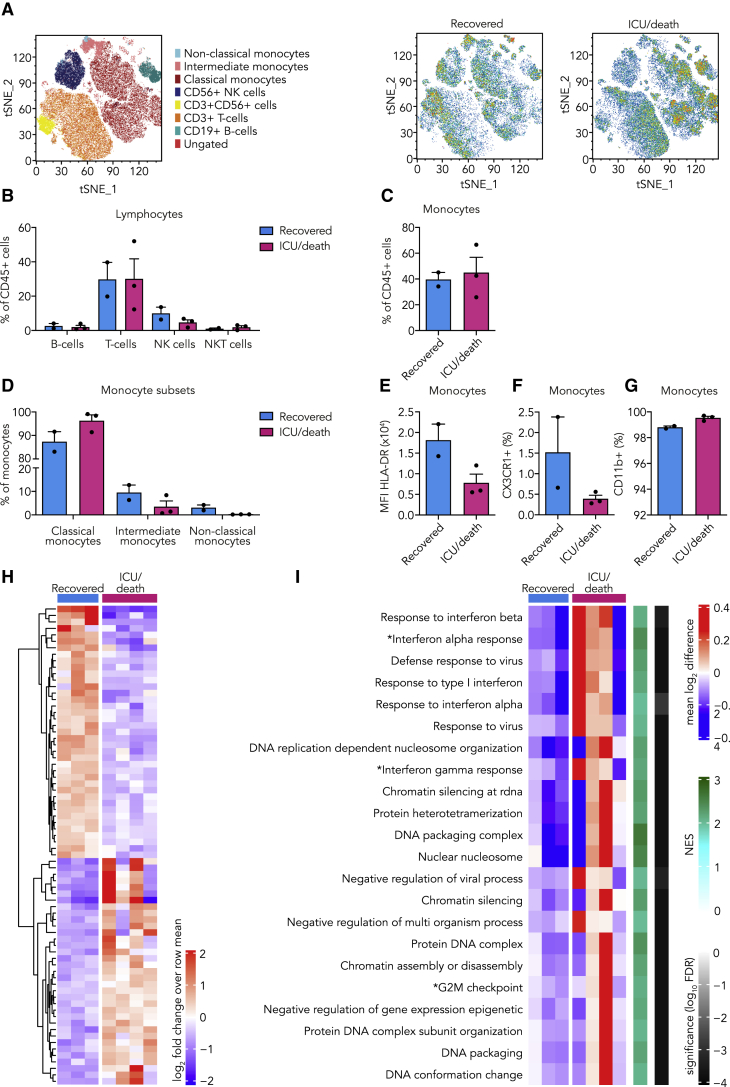
Innate Immune Response in COVID-19 Patients 5 Days after Admission and the Relation to Outcome(A–G) PBMCs isolated from COVID-19 patients 5 days after admission were analyzed using flow cytometry (n = 2 for COVID-19 patients who recovered, n = 3 for COVID-19 patients who required ICU admission or died).(A) tSNE plots showing unsupervised clustering on the expression of 10 markers (CD45, CD14, CD16, CD3, CD19, CD56, HLA-DR, CD11b, CCR2, and CX3CR1) in COVID-19 patients who recovered versus those who required ICU admission or died.(B) Quantification of lymphocytes using gating strategy shown in Figure S1C indicated no differences between both COVID-19 patient groups.(C) Quantification of overall monocytes showed no difference between COVID-19 patient groups.(D) Subset analysis of monocytes revealed increased amounts of non-classical monocytes (CD14+, CD162+) in COVID-19 patients who recovered compared to those who required ICU admission or died.(E and F) Expression of HLA-DR (E) and numbers of CX3CR1-expressing monocytes (F) were increased in COVID-19 patients who recovered compared to those who required ICU admission or died.(G) CD11b expression on monocytes did not differ between both COVID-19 patient groups.(H and I) Transcriptome analysis was performed on isolated monocytes of COVID-19 patients 5 days after admission. (n = 3 for COVID-19 patients who recovered, n = 4 for COVID-19 patients who required ICU admission or died).(H) Heatmap of differentially expressed genes (p < 0.001) (listed in Table S4) between COVID-19 patients who recovered versus those who required ICU admission or died.(I) Heatmap of GO pathways and hallmark pathways that are significantly enriched (FDR, <0.01) in COVID-19 patients who recovered compared to those who required ICU admission or died (∗, hallmark pathways).Data are presented as mean ± SEM.